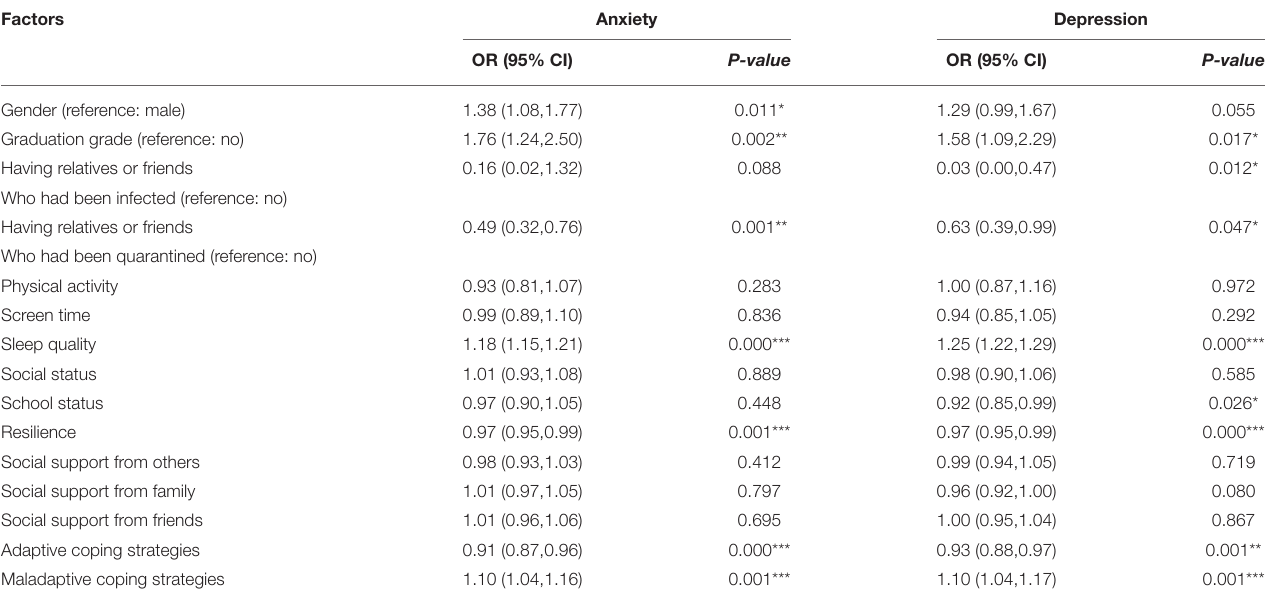
TABLE 3 | The results of the logistic regression model for anxiety and depression. Factors Anxiety